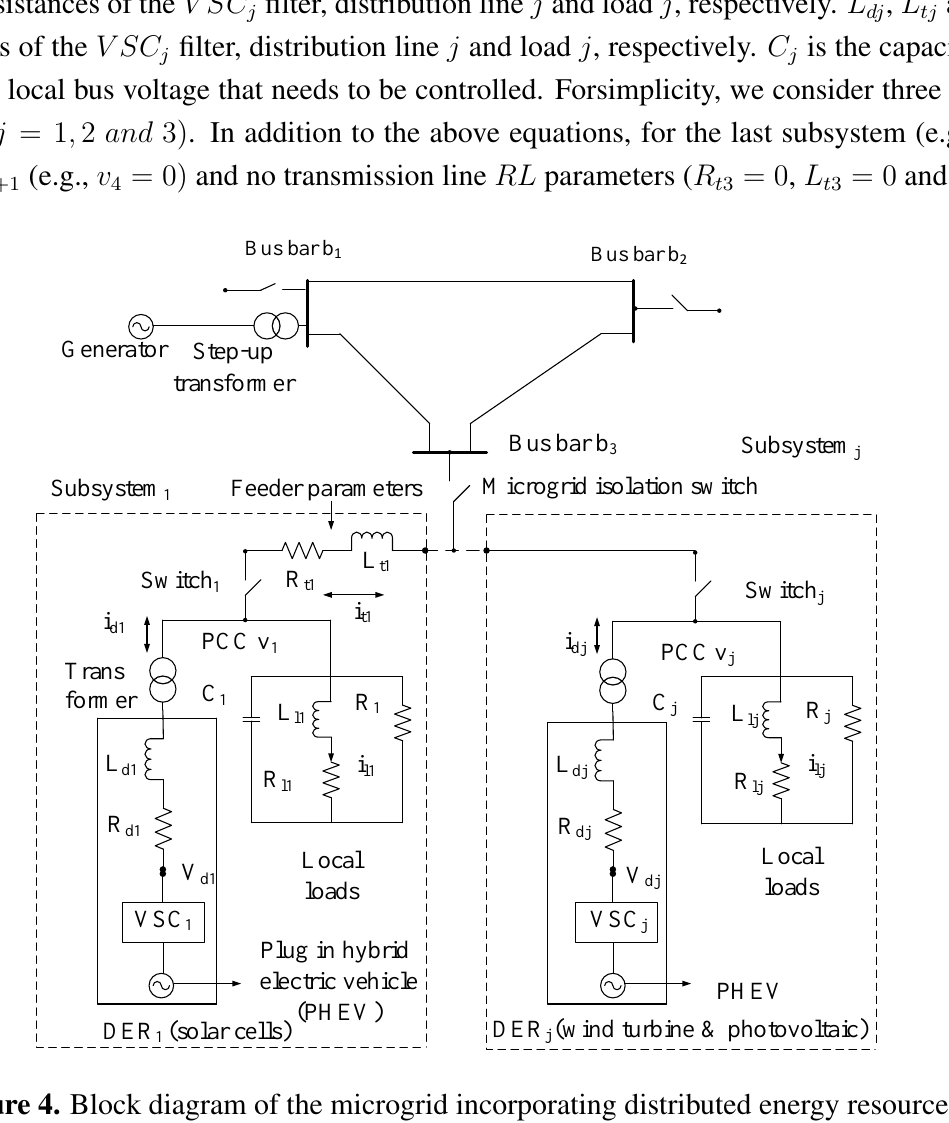
Figure 4. Block diagram of the microgrid incorporating distributed energy